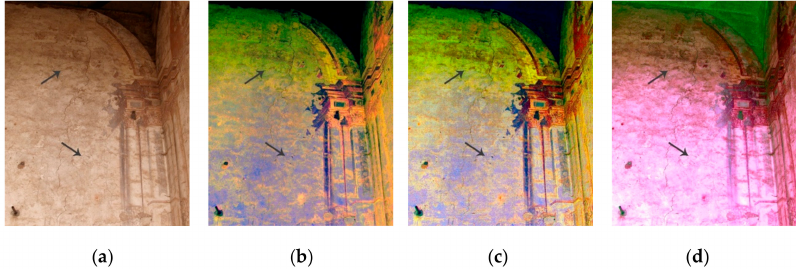
Figure 9. Analysis of central facing (CW): ( a ) Initial RGB image; ( b ) YBK filter highlighting decontextualized remains in moulding; ( c ) LDS filter with similar results on underlying features, whilst improving visibility in the upper section; ( d ) RGB0 filter providing greater clarity in the contours of the upper